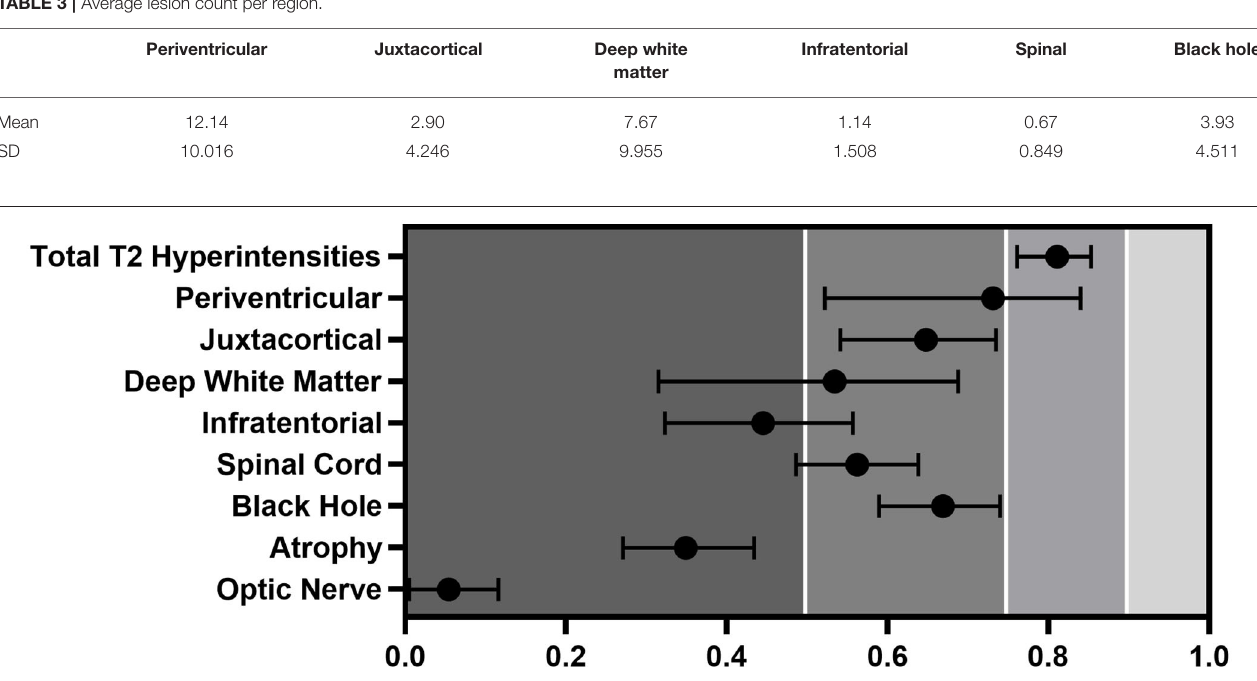
FIGURE 1 | ICC of the different regions evaluated by all five raters. Error bars represent